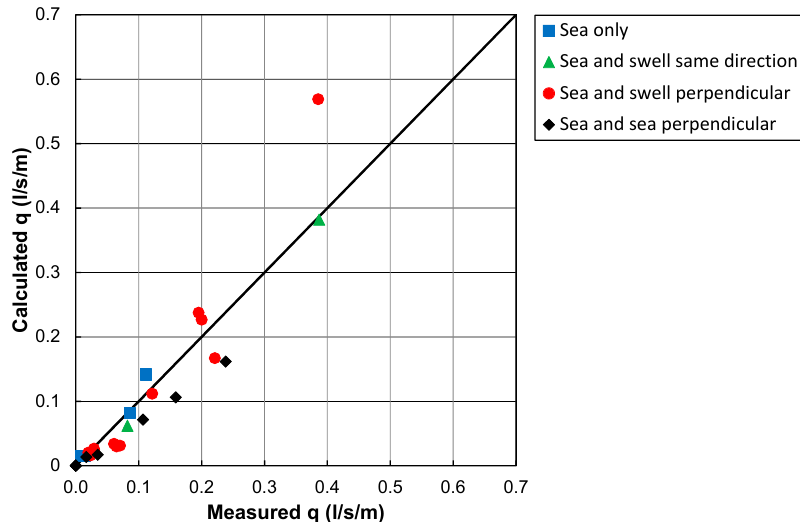
Figure 6. Measured versus calculated wave overtopping, using Equation (12).